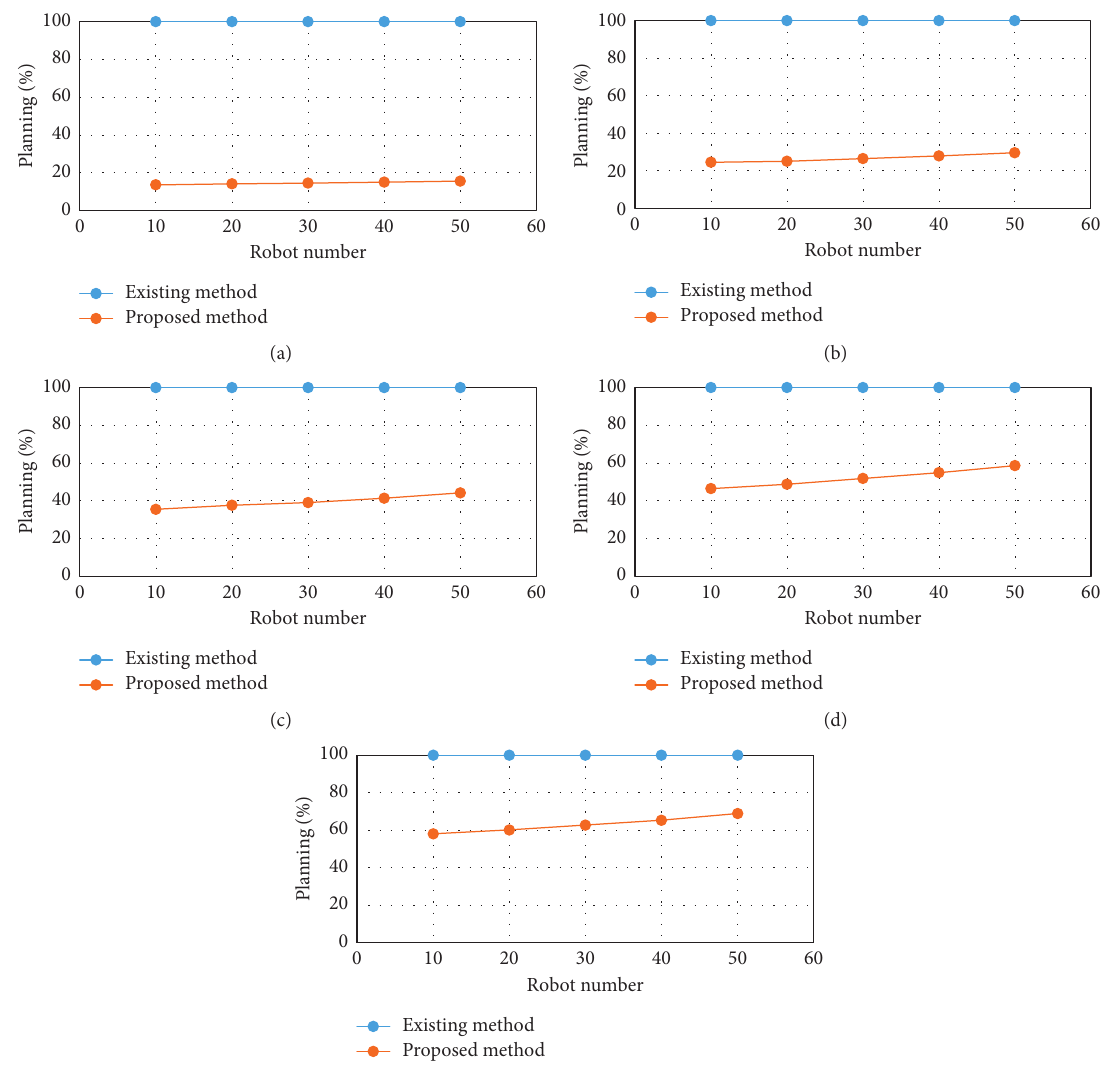
Figure 9: Planning percentage in a warehouse environment of 50 × 34 4-neighbor grids. (a) p (e) p u �